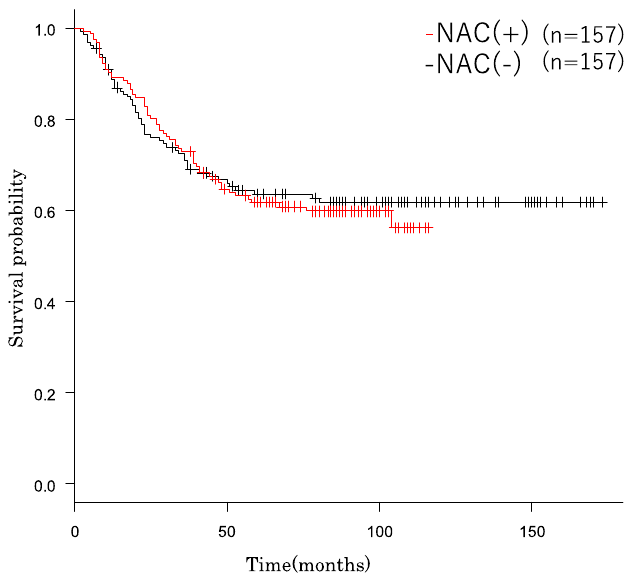
Figure 1 Survival curve A comparison of neoadjuvant chemotherapy (+) versus neoadjuvant chemotherapy (–) in advanced gastric cancer: A propensity score matching analysis NAC, neoadjuvant